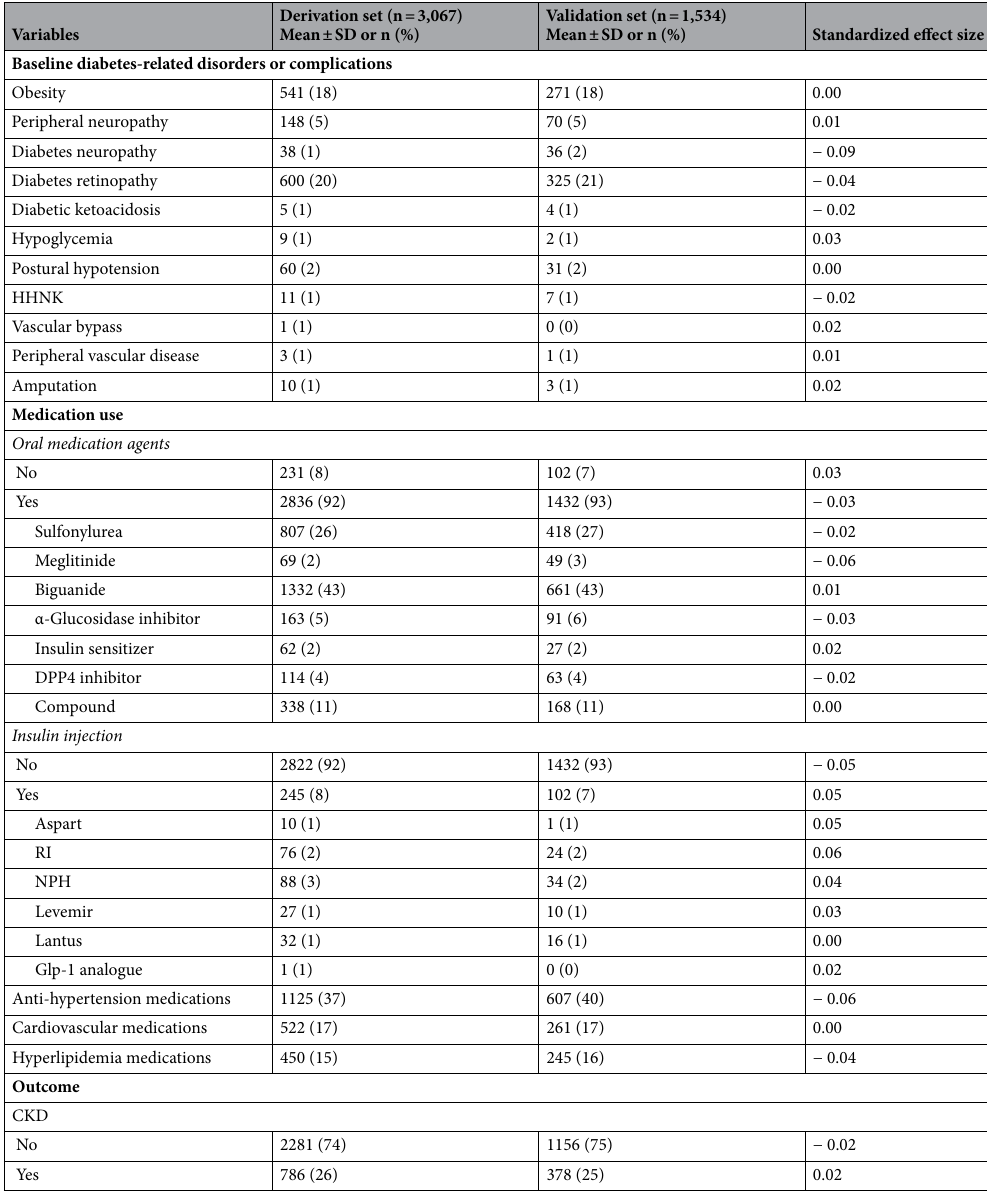
Table 1. Baseline characteristic of study population according to derivation and validation sets. The standardized effect size defined as the difference of two population means (or proportions) and it is divided by the standard deviation. ACR albumin to creatinine ratio, variation of SBP variation of systolic blood pressure, variation of DBP variation of diastolic blood pressure, variation of FPG variation of fasting plasma